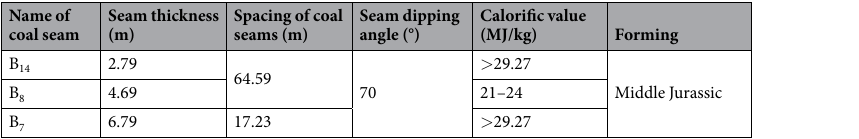
Table 1. Characteristics of coal seams at Daquan Lake fire district in